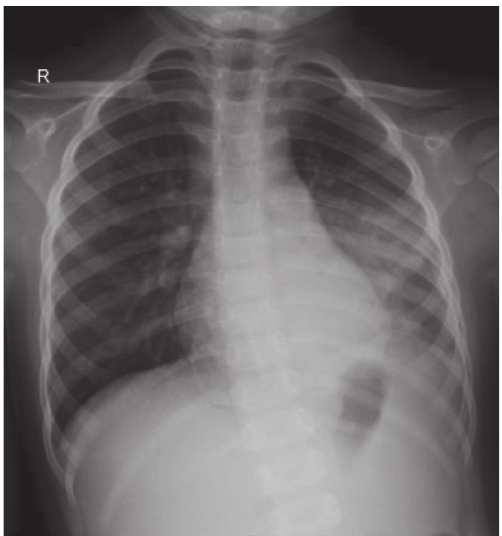
Figure 1: AP-supine chest radiograph: visible consolidation in the left inferior lobe of the lungs. The right lung had no apparent